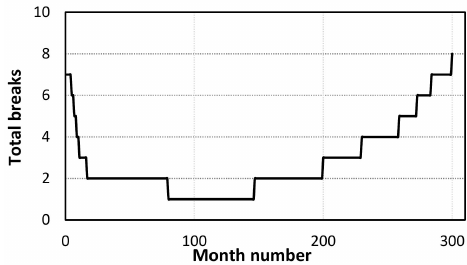
Figure 4. Cumulative CO 2 release in the operation phase (1992–2016).